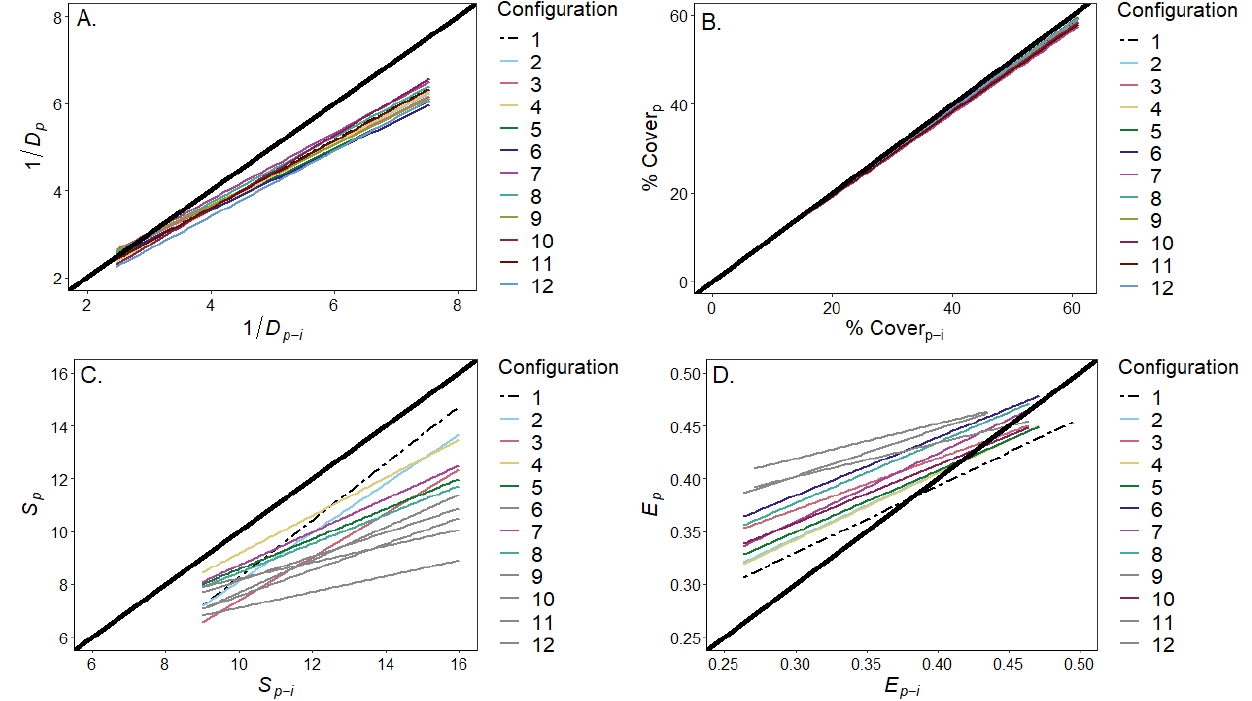
Figure 5. Regressions between field (e.g., S p-i ) and Photogrid (e.g., S p ) vegetation metrics from the 2019 data, shown for the 12 Photogrid configurations of ( A ) Simpson’s species diversity (1/D); ( B ) % Cover; ( C ) species richness (S); and ( D ) Simpson’s evenness. The heavy black lines show the one-to-one relationship. Dashed lines represent the regression between Photogrid configuration 1 (highest sampling effort) and the field point-intercept method; colored lines are those configurations that did not produce significantly different results from configuration 1, and grey lines represent those that were significantly different than configuration 1, based on a Tukey HSD test. There was no significant difference among the configurations for 1/D p or % Cover p . Five configurations produced significantly lower values for S p , and three configurations produced significantly greater values for E p when compared to configuration 1.